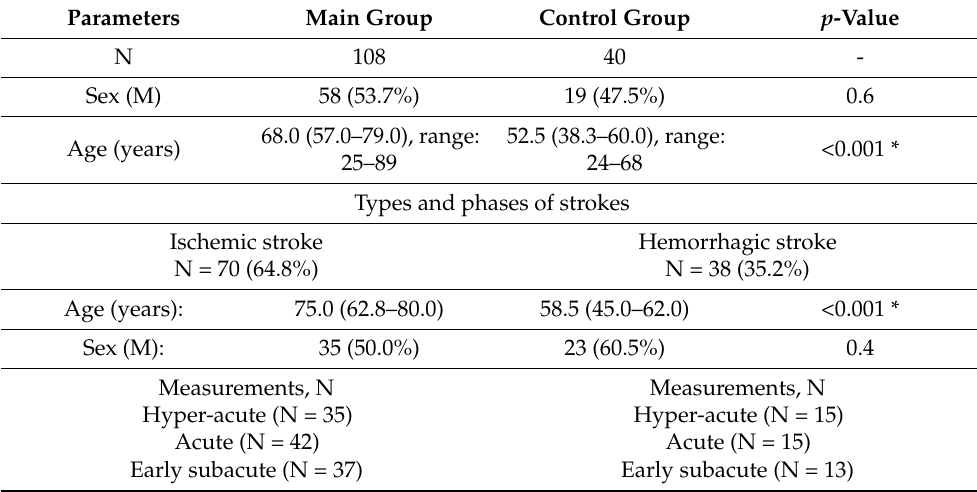
Table 1. Baseline characteristics of the patient cohort in the